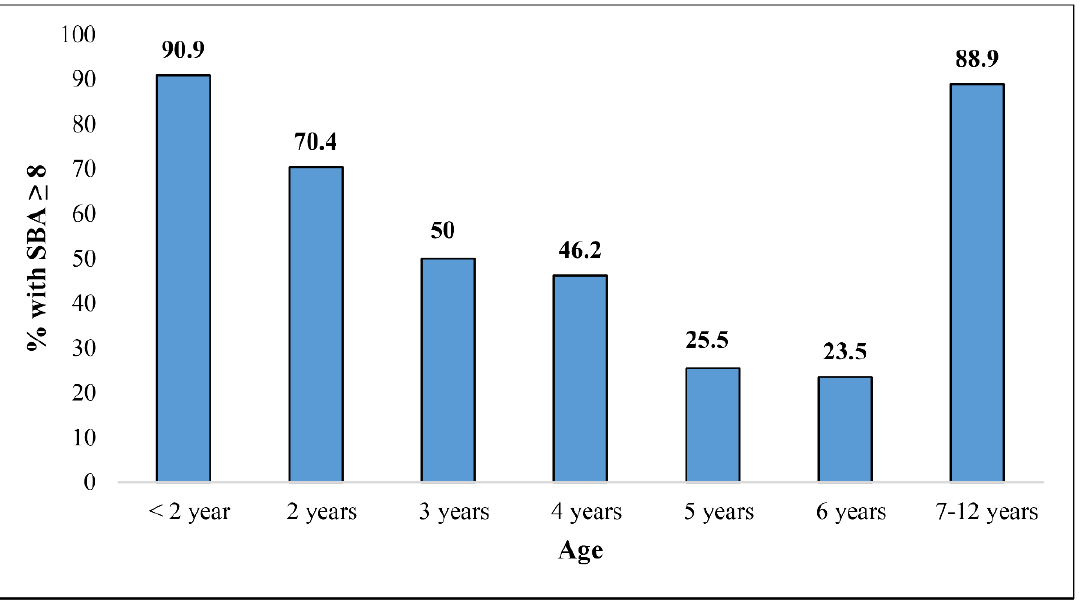
Figure 1. Percentage of children with MenC rSBA titers ≥ 8 by age at enrollment post MCC vaccine.